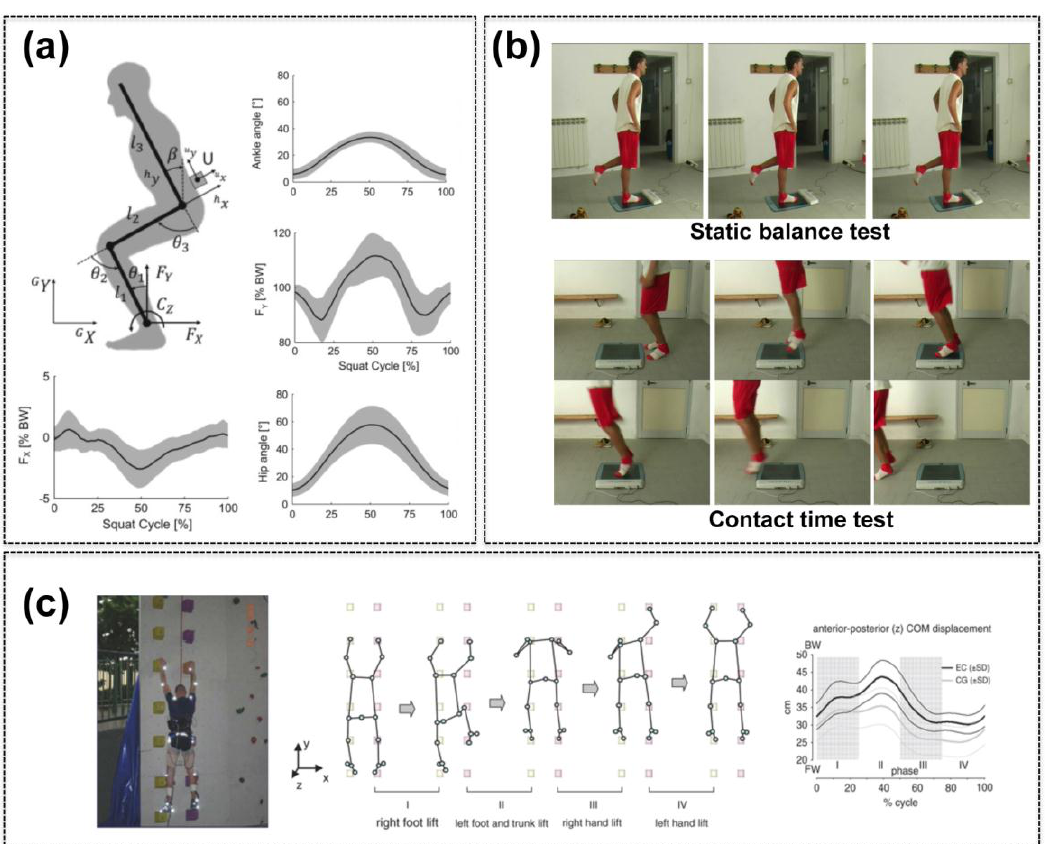
Figure 3. Examples of MEMS for sport and leisure applications. ( a ) IMU mounted on the trunk for estimating squat exercise dynamics. Adapted with permission from [91] (copyright: Elsevier); ( b ) MEMS pressure sensors used to assess balance abilities and non-cyclic rapidity of soccer players. Adapted with permission from [100] (copyright: Creative Commons); ( c ) Climbing dynamics quantified by means of kinematic data associated with vertical plantar reaction forces, measured through MEMS capacitive sensors. Adapted with permission from [104] (copyright: John Wiley &